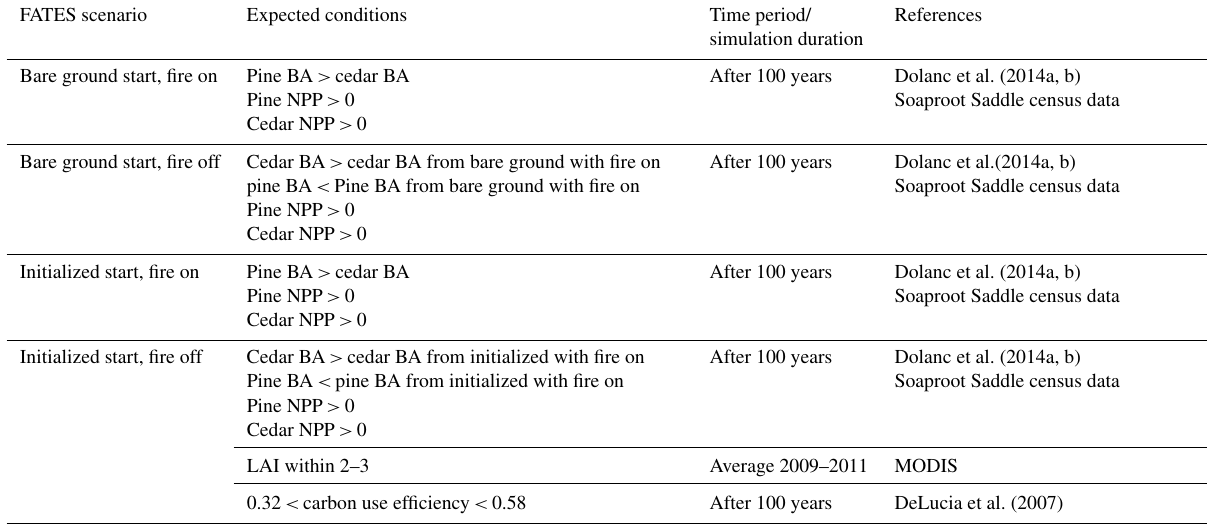
Table 1. Ecologically expected outcomes for each disturbance (fire on vs. off) and initial condition (bare ground vs. initialized stands) sce- nario for FATES simulations at the Soaproot Saddle site in the Sierra Nevada of California. BA = basal area; NPP = net primary productivity. FATES